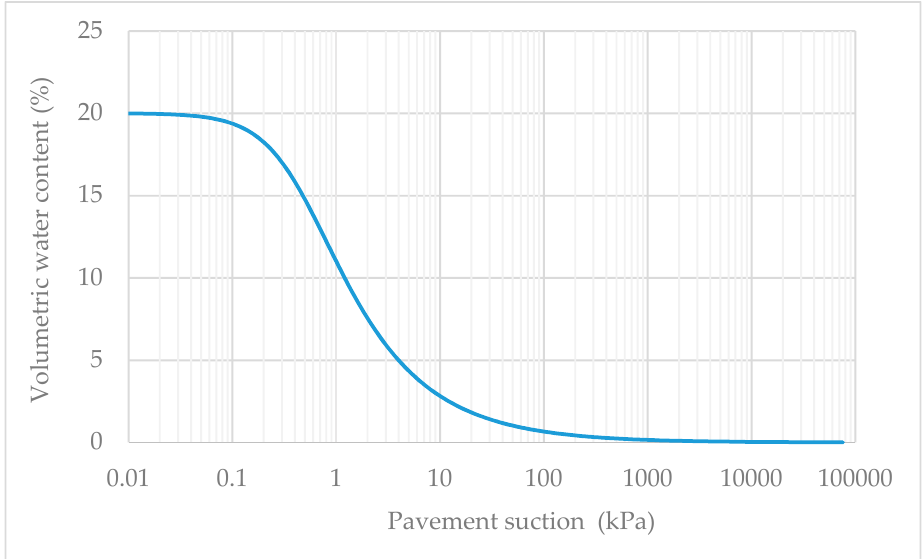
Figure 5. SWCC curve of the PFC pavement.